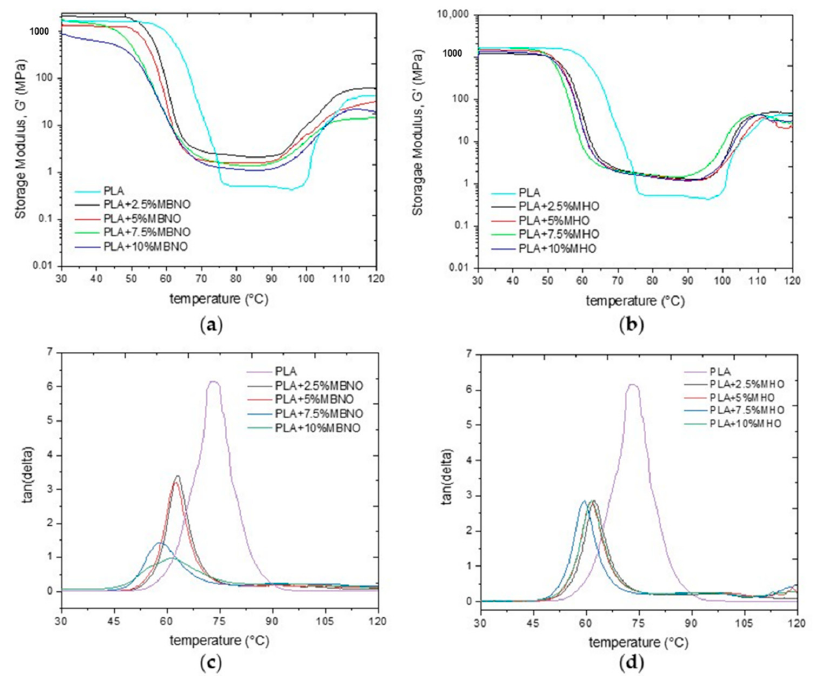
Figure 10. Storage modulus ( a , b ) and damping factor ( c , d ) of unplasticized PLA and PLA plasticized with different content of MBNO and MHO as a function of temperature.